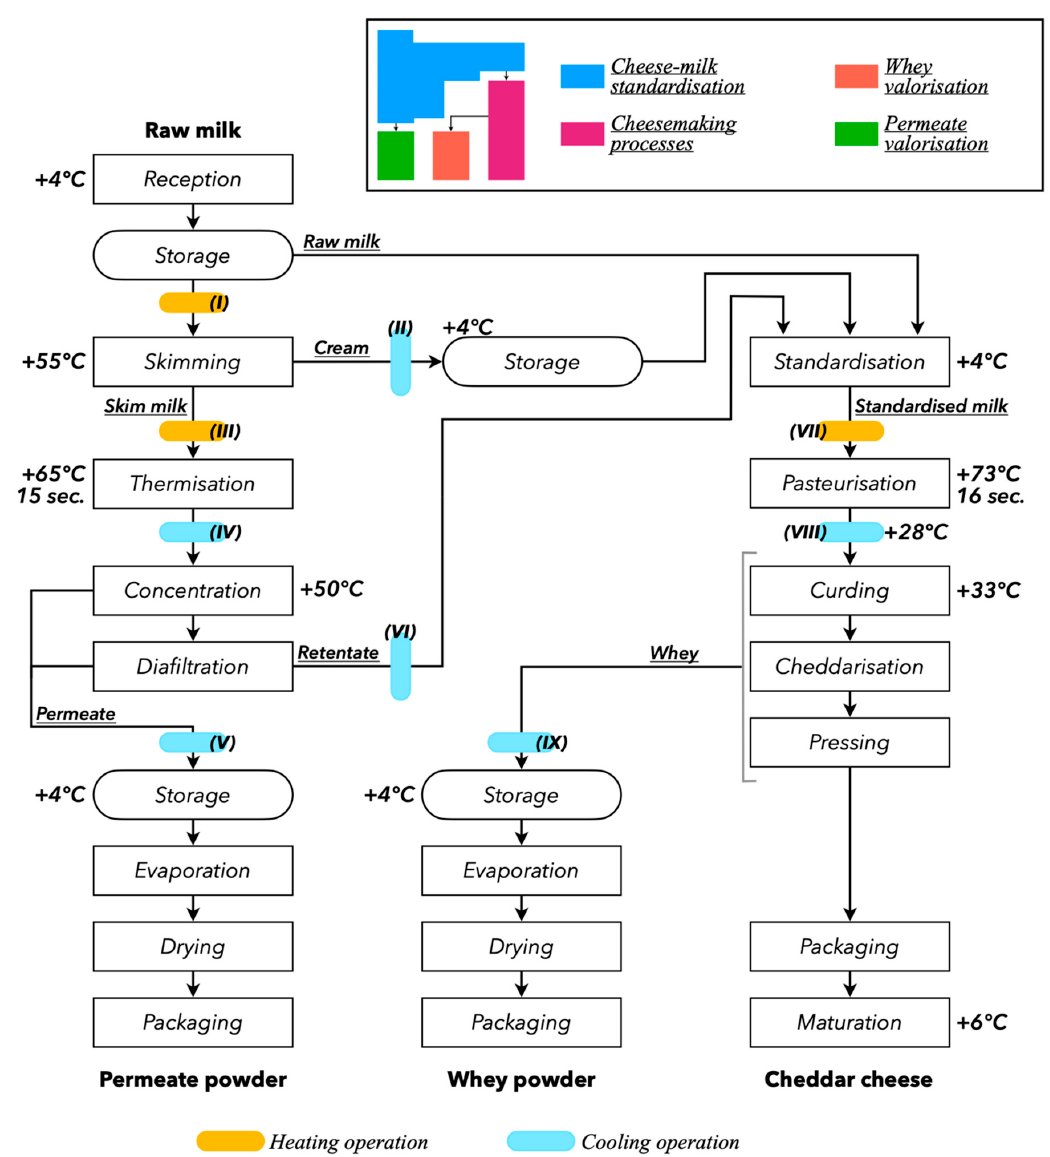
Figure 1. Process flow diagram of scenarios A and B. In scenario A, the concentration step is carried out using ultrafiltration membranes (10 kDa) until a volume concentration factor (VCF) of 3.5 is reached, followed by continuous diafiltration (2.0 DV). In scenario B, the concentration step is carried out using microfiltration membranes (0.1 µm) until a VCF of 3.0 is reached, followed by discontinuous diafiltration (2.0 DV each).